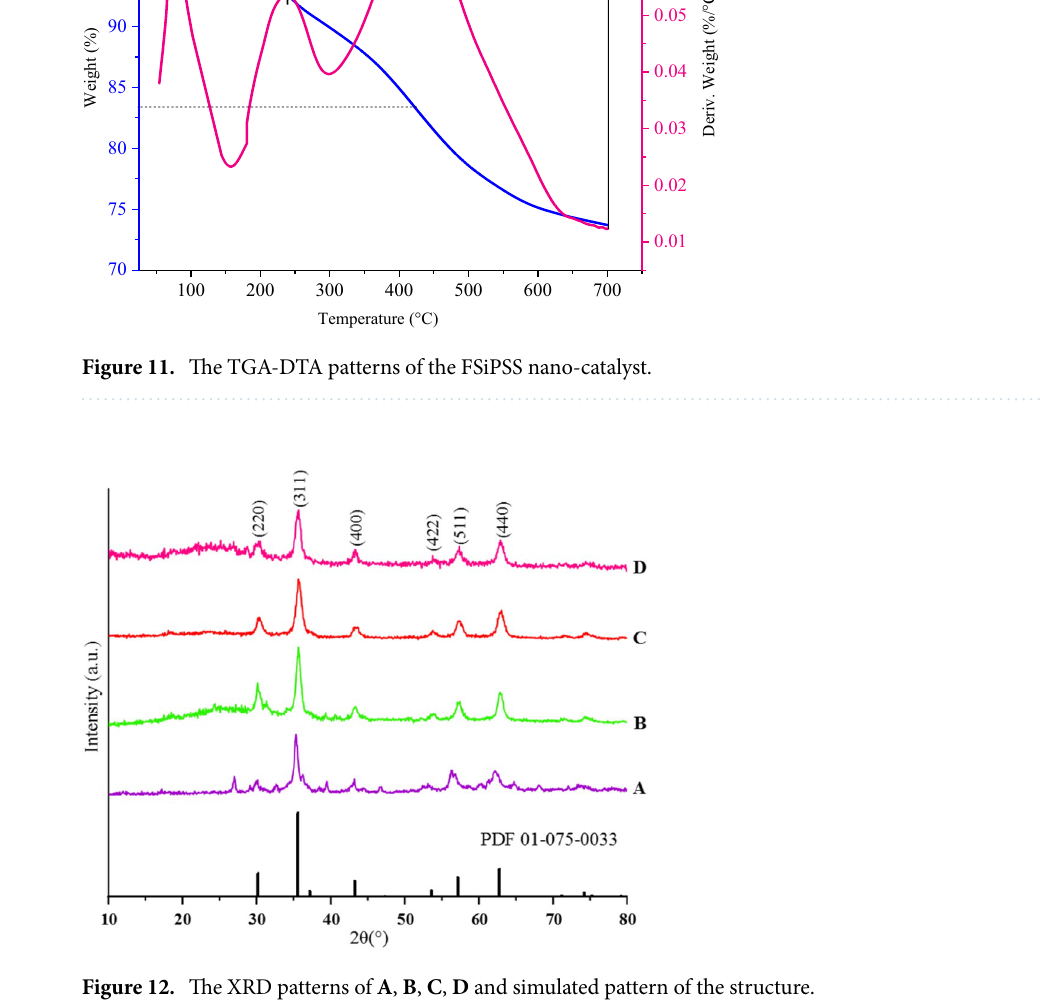
Figure 12. The XRD patterns of A , B , C , D and simulated pattern of the